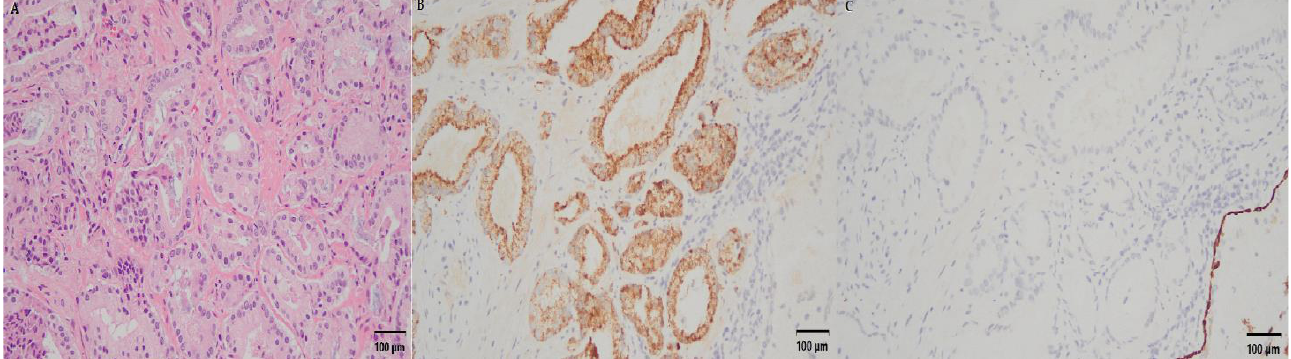
Figure 7. The Gleason score of the excised specimen was 3 + 4. ( A ) Microscopically, it revealed angulated and elongated acini that were haphazardly distributed in the stroma. ( B ) The tumor acini were positive for AMACR; these were negative in the basal layer. ( C ) The tumor was stained with p63 immunostains.